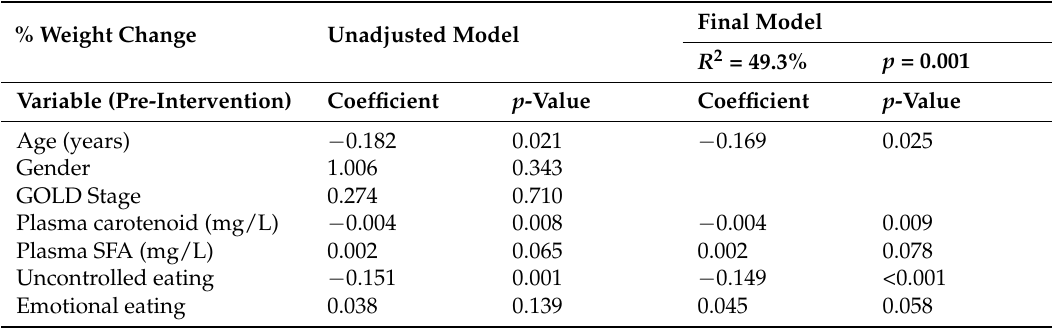
Table 5. Multiple linear regression examining baseline eating behaviours, dietary quality, demographics and lung function as predictors of change in %